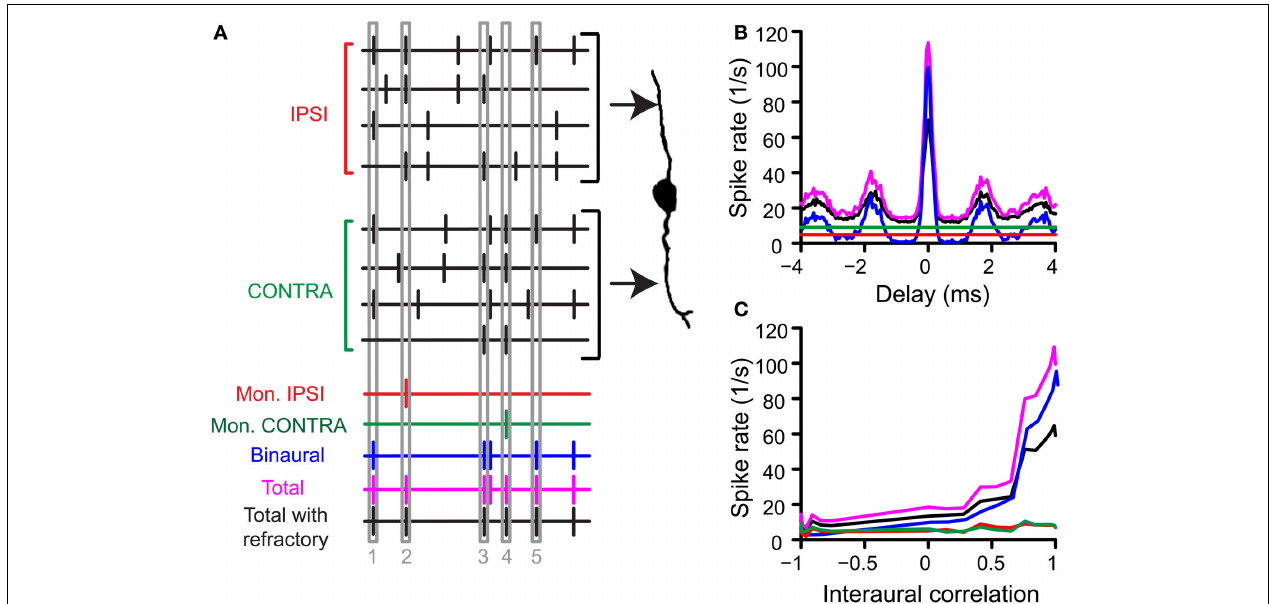
FIGURE 1 | Simulation of coincidence detection. (A) Depiction of one run of the coincidence process. In this example, N = 4, thr mon = 3, thr bin = 2 and cw = 50 μ s.Seetextfordetails. (B) ExampleofpseudobinauralNDF.Thetraces shown are the average rates of 3 real runs with the same parameters as in (A) .